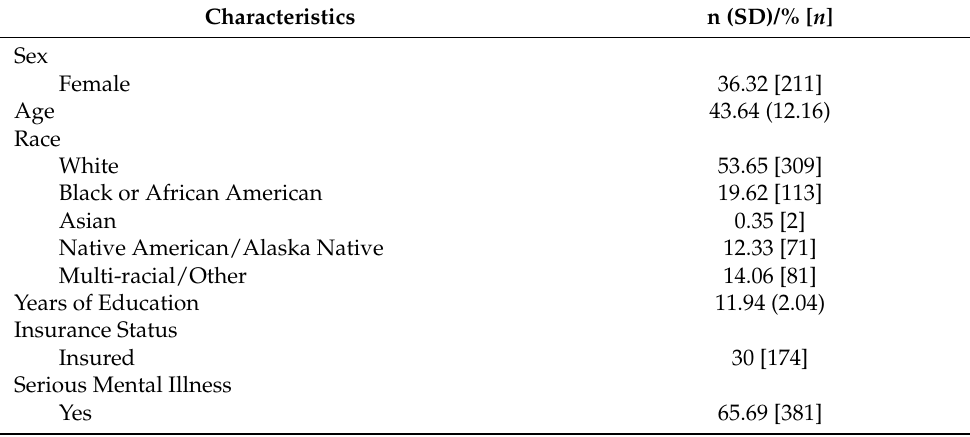
Table 1. Sample characteristics ( N = 581 adults experiencing homelessness).